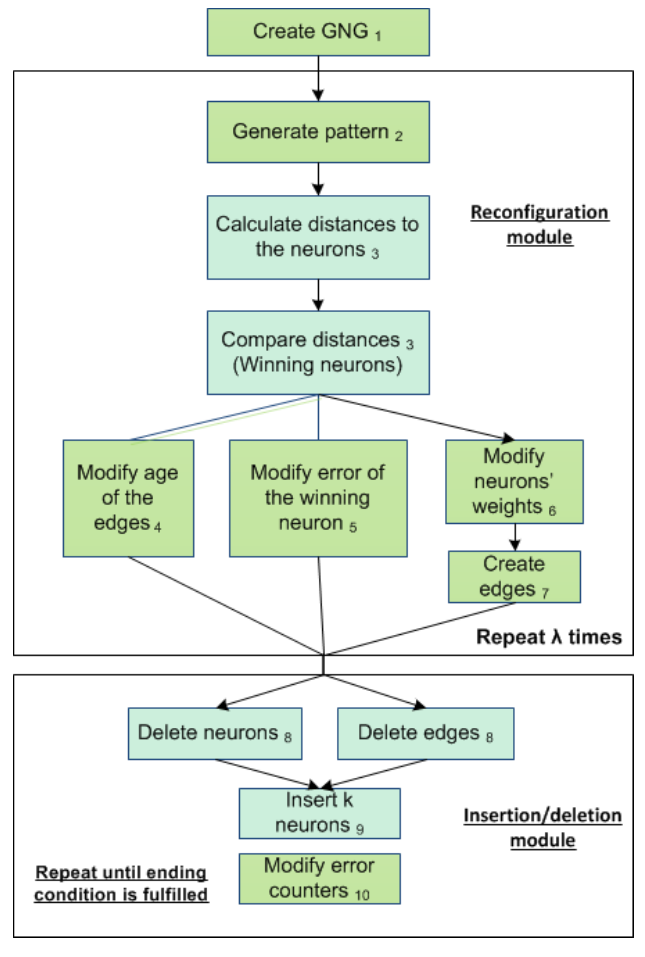
Figure 2. Growing neural gas (GNG) learning algorithm showing the parallel